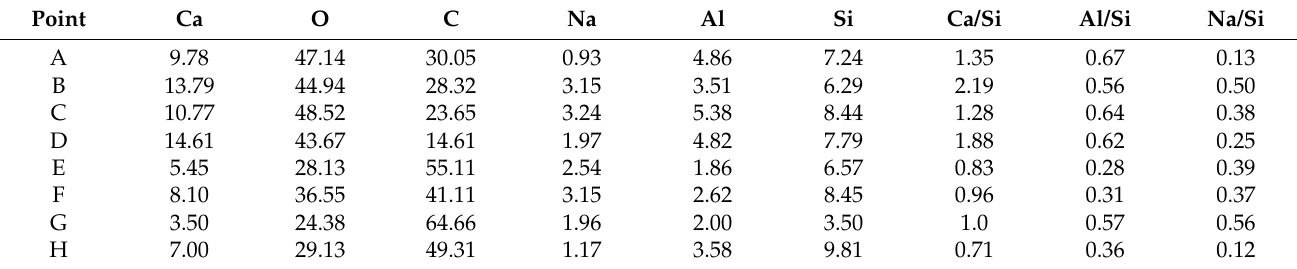
Table 1. Atomic percentage at each point in the EDS